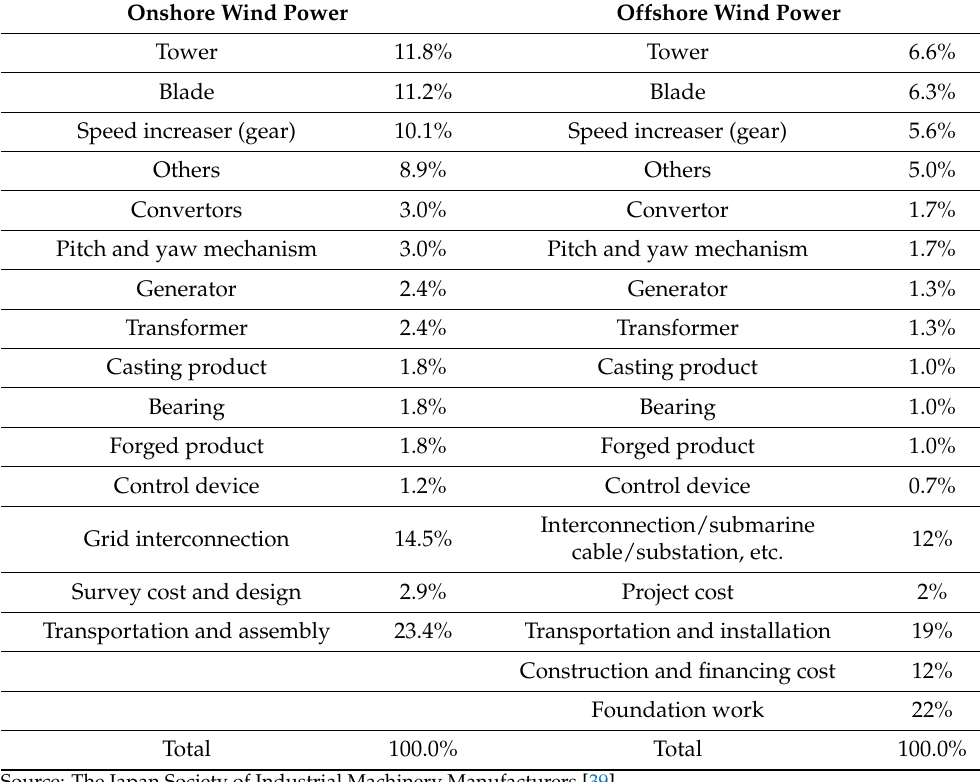
Table A4. Cost composition of wind power-generation equipment/facility